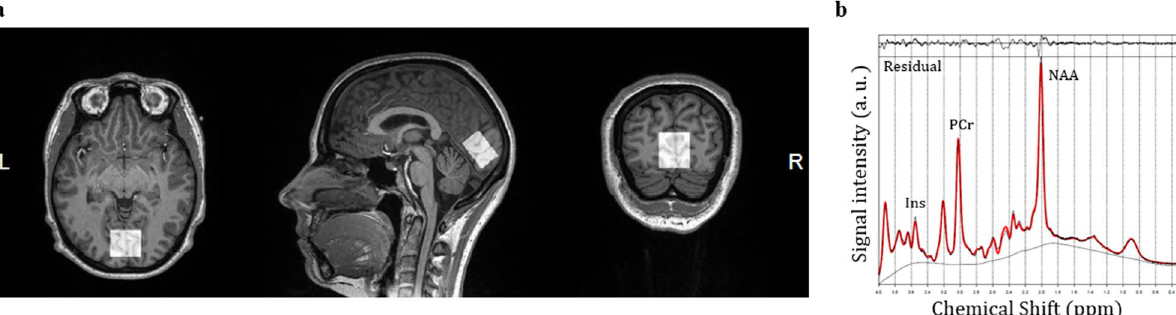
Figure 1. Voxel placement for 1 H MRS in the occipital lobe ( a ), and a representative example of a fitted spectrum ( b